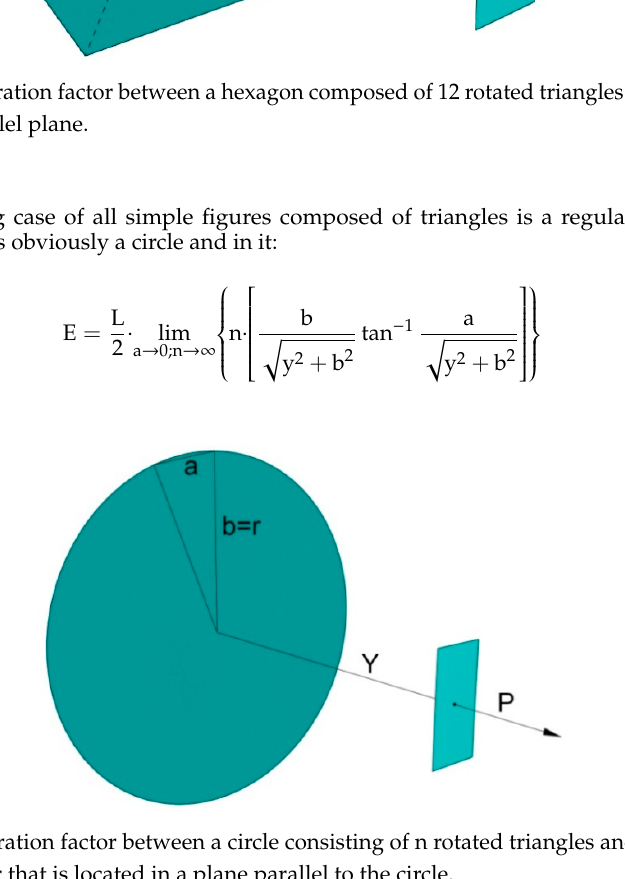
Figure A3. Configuration factor between a circle consisting of n rotated triangles and a point from the normal to the center that is located in a plane parallel to the circle.